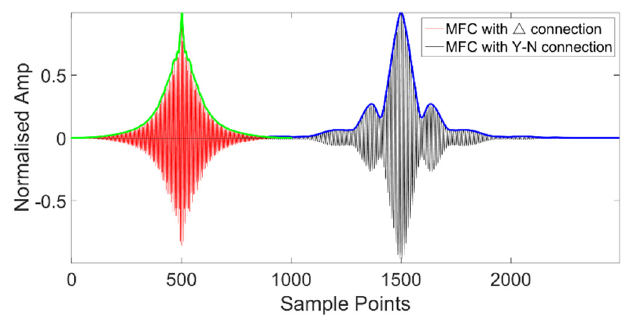
Figure 17. Autocorrelation results of typical self-healing signals.